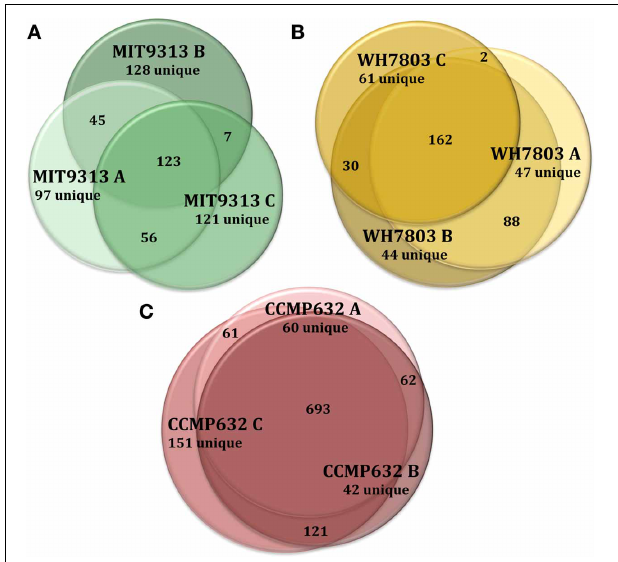
FIGURE 1 | Venn diagrams showing the degree to which triplicate cultures of representative phytoplankton strains share DOM P features. Each culture is represented by a circle, the area of which is proportional to the total number of features identified in that sample. The degree of overlap between circles is proportional to the number of shared features. Prochlorococcus str. MIT9313 replicates had the most variation of any strain tested (A) , while P. tricornutum (CCMP632) replicates had the least variation (C) . Synechococcus str. WH7803 replicates exhibited an average degree of variation indicative of most strains tested in this study (B) . For more detailed information regarding replicate correlations, see Table 3 .